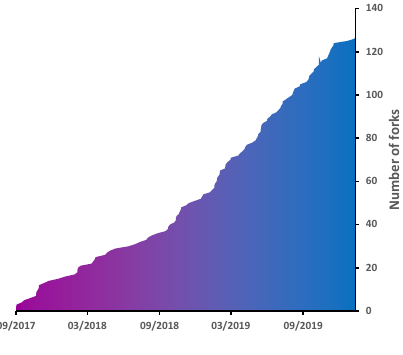
Figure 2. Number of forks of the NANOAOD companion tool as a function of time since its